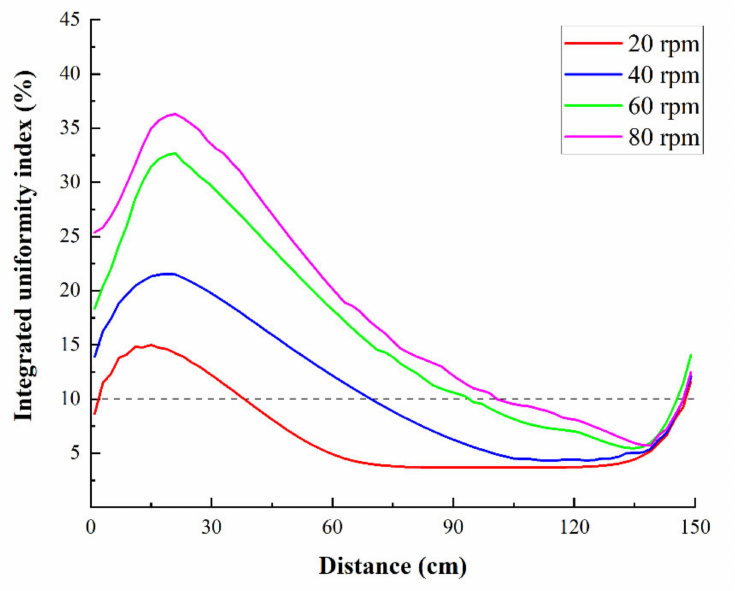
Figure 7. The distribution of velocity uniformity along the path at different speeds in straight